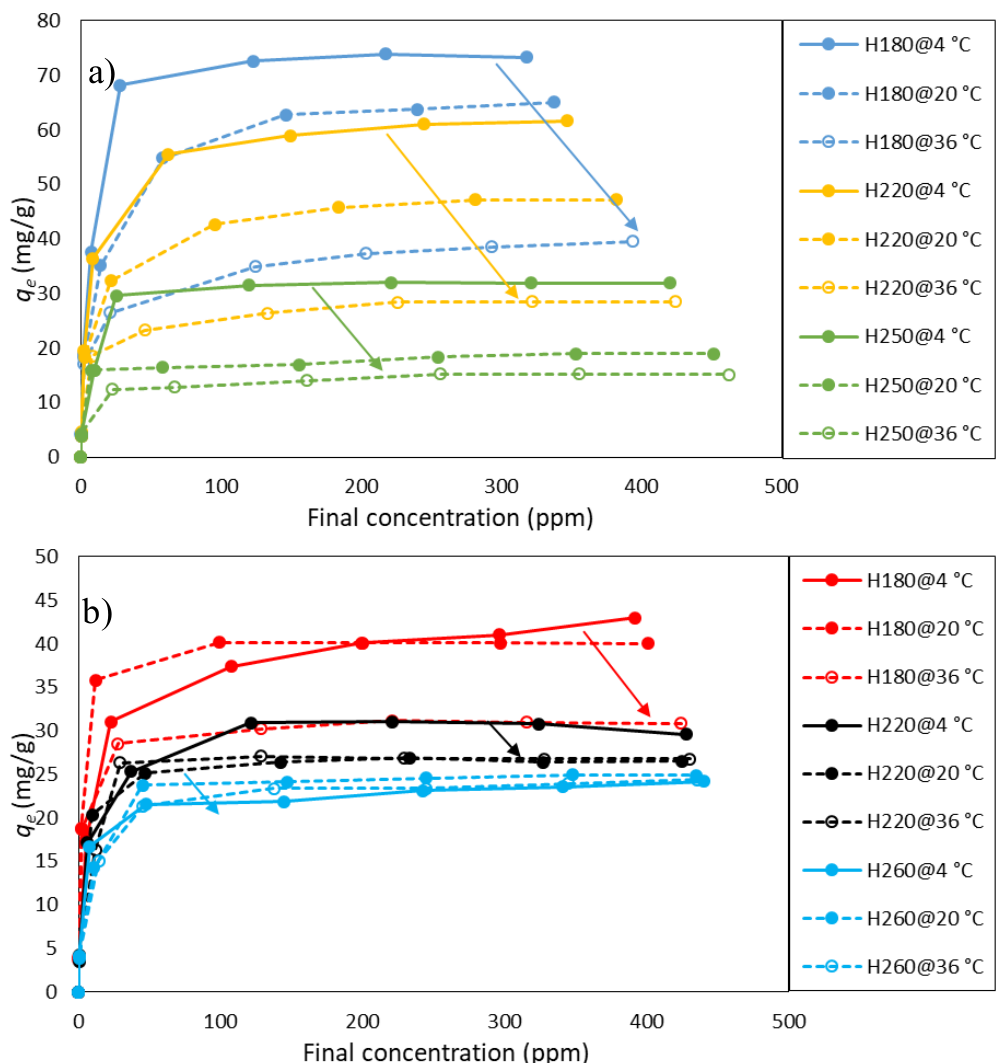
Figure 5. Equilibrium adsorption of dye at different temperatures on hydrochars produced from ( a ) citrus wastes, ( b ) winery wastes.